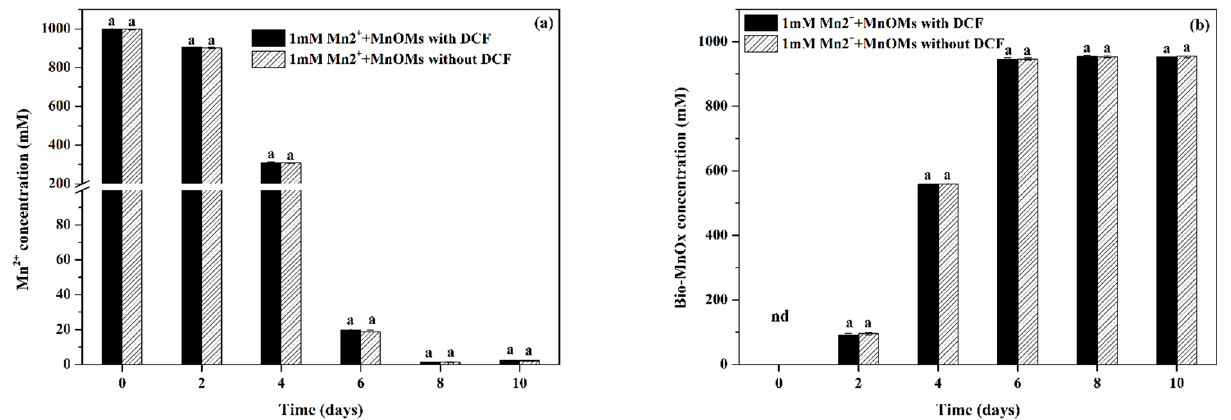
Figure 6. Concentration variation of ( a ) Mn 2+ and ( b ) Bio-MnOx over time. The same letters above the error bars showed insignificant differences between control and treatment ( p < 0.05).